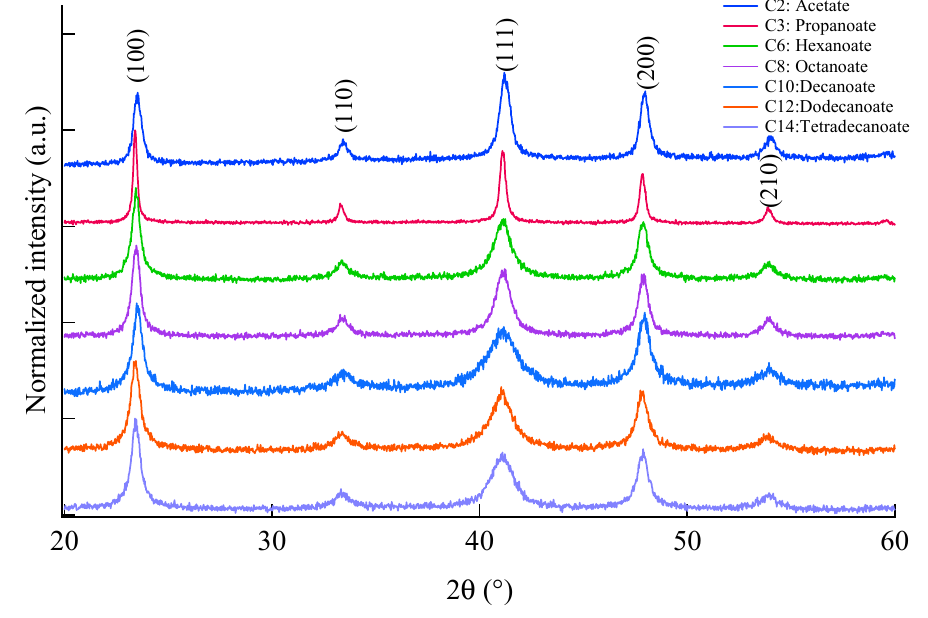
Figure 3. X-ray diffractometry (XRD) patterns of samples prepared from different starting reagents. Previously crystal structure and planes for (100), (110) and (111) of copper nitride are shown in Figure 4 for ease of imagination.